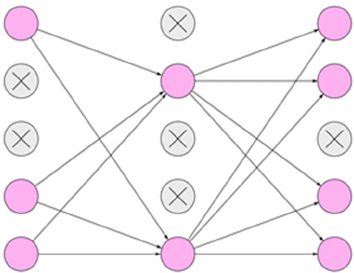
Figure 14. Full connection after the dropout mechanism is applied.